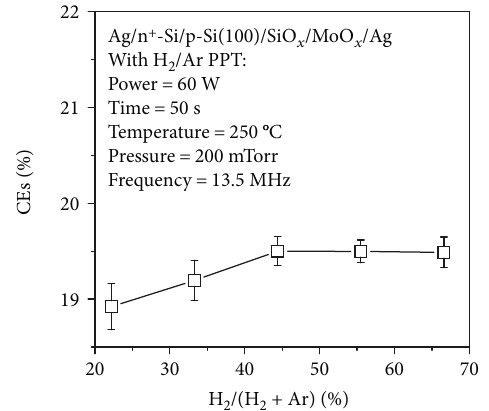
/ ð H + Ar Þ ratio curves of the SPSSCs. The Figure 3: CEs vs. H 2 2 treated parameters were addressed at 60 W for 50s and 250 ° C.